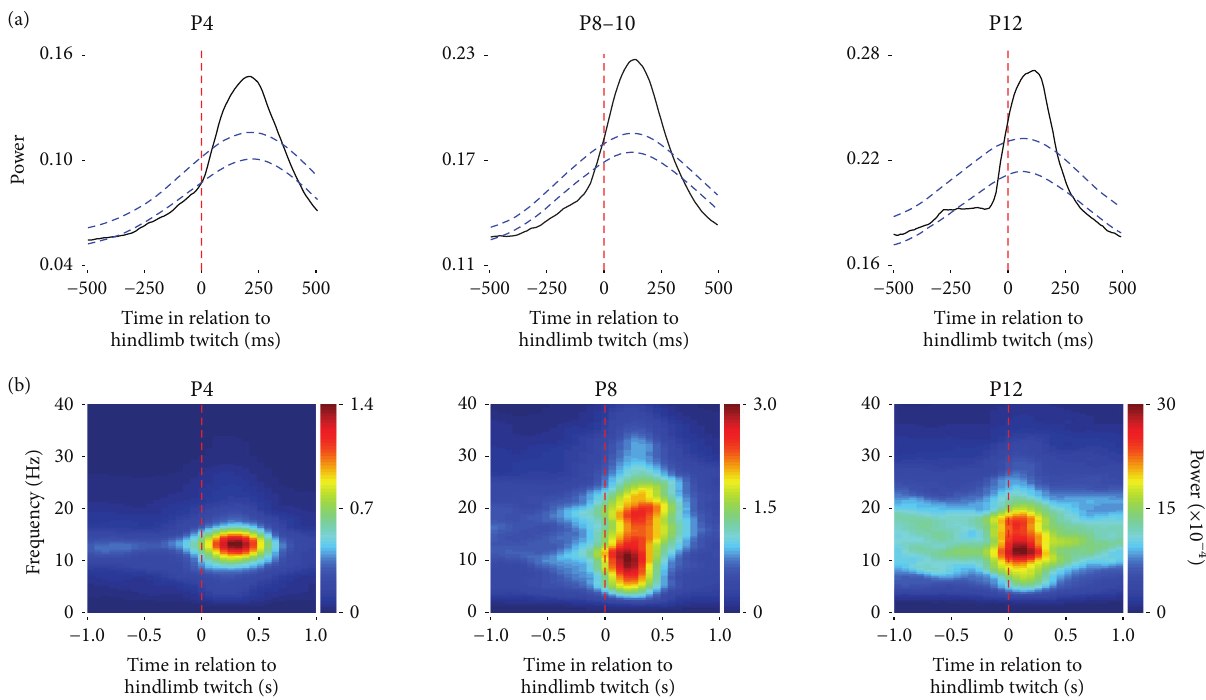
Figure 2: Spindle burst activity in relation to twitches in P4, P8–10, and P12 rats. (a) Waveform averages of local field potentials (LFPs) recorded from the hindlimb region of motor cortex (P4: 𝑛 = 1,172 twitches across 6 pups; P8–10: 𝑛 = 4,047 twitches across 11 pups; and P12: 𝑛 = 789 twitches across 6 pups). Peak power in the LFP occurs after hindlimb twitches (dashed red lines). Acceptance bands ( 𝑝 < 0.05 ) are also shown (dashed blue lines). Adapted from Tiriac et al., Current Biology , 2014 [11]. (b) Twitch-triggered time-frequency spectrograms of LFPs from individual P4 (168 twitches), P8 (294 twitches), and P12 (135 twitches) rats. Average peak power at spindle frequency (10–15Hz) is prominent after hindlimb twitches (dashed red